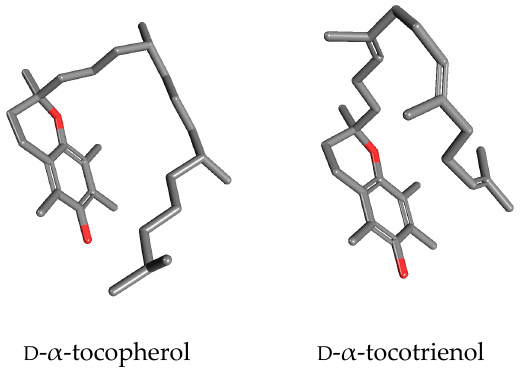
Figure 1. Structural differences between α -tocotrienol and α -tocopherol (from https://pubchem.ncbi.nlm.nih.gov/).